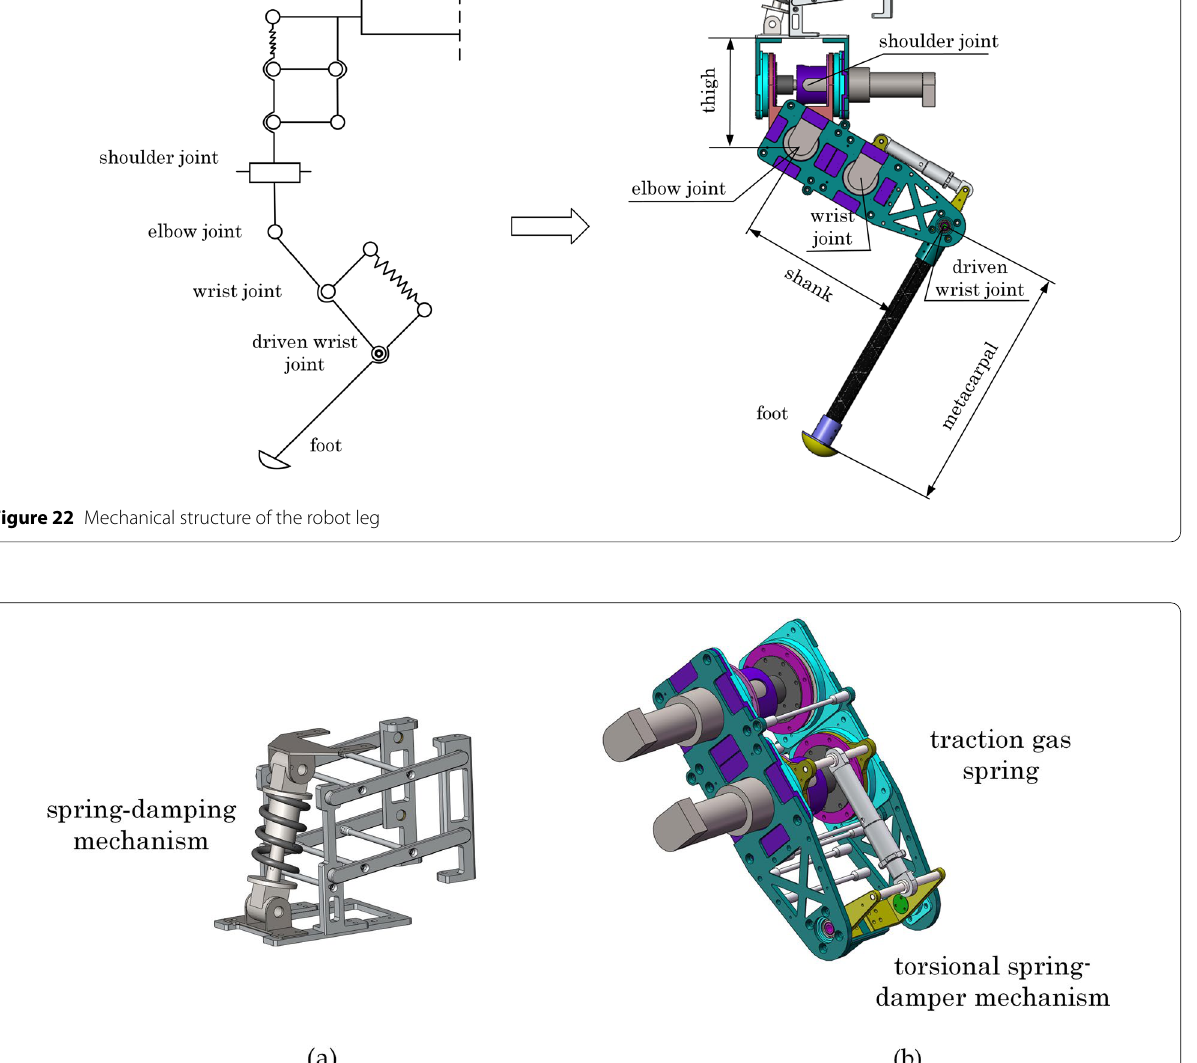
Figure 23 Mechanical structure of the buffer systems: a mechanical structure of the second-stage buffer system, b parallelogram mechanism with the traction gas